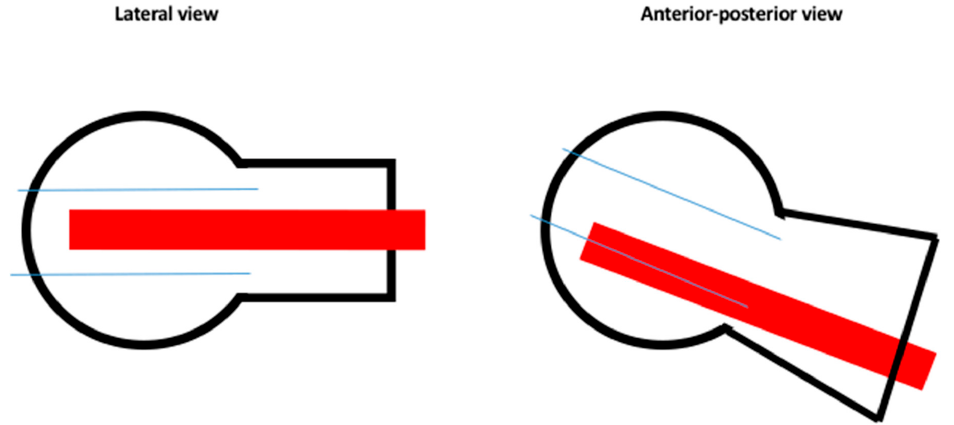
Figure 1. Aimed lag screw / blade position. The aimed position of the lag screw / blade in the femoral head and neck fragment according to departmental guidelines.